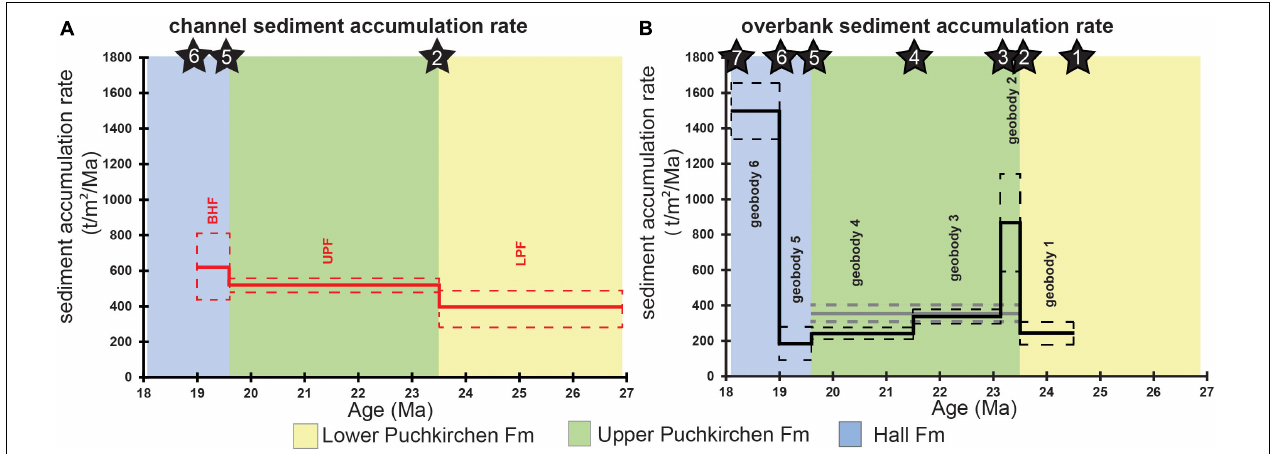
FIGURE 10 | Calculated sediment accumulation rates [SARs, (t/m 2 /Ma)] of the channel (A) and the northern overbanks (B) , stars indicate the bio- and/or chemostratigraphic constrains of Well H (see Table 1 ); 1 = Peak 1 in δ 13 C carb ; 2 = U/LPF boundary (Peak 4 in δ 13 C carb ); 3 = FO Helicosphaera carteri ; 4 = Peak 11 (carbon isotopy Well H); 5 = Peak 14 (carbon isotopy Well H); 6 = mfs and Sr-Isotopy from Maierhof; 7 = Hall/Innviertel boundary (Grunert et al., 2013). The gray bar in (B) indicates the combined, average SAR during the UPF onto the northern overbanks. SARs in the channel show variation within their 1 σ standard deviation (SD). Note that during geobody 6 (star 6–7) channel sedimentation had ended; therefore, geobody 6 does not represent an overbank